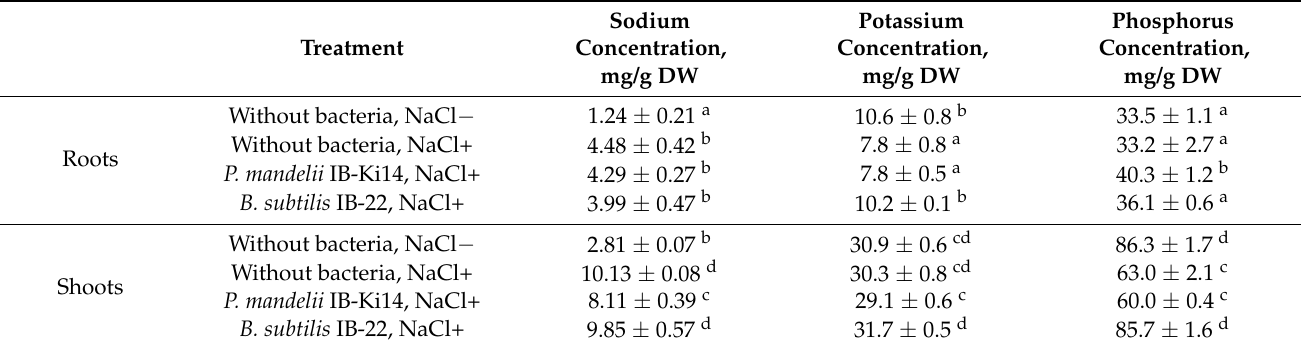
Table 2. Effect of 100mM NaCl and bacterial treatment with Pseudomonas mandelii IB-Ki14 and Bacillus subtilis IB-22 on sodium, potassium and phosphorus concentration in the roots and in the shoots of 11-day-old wheat